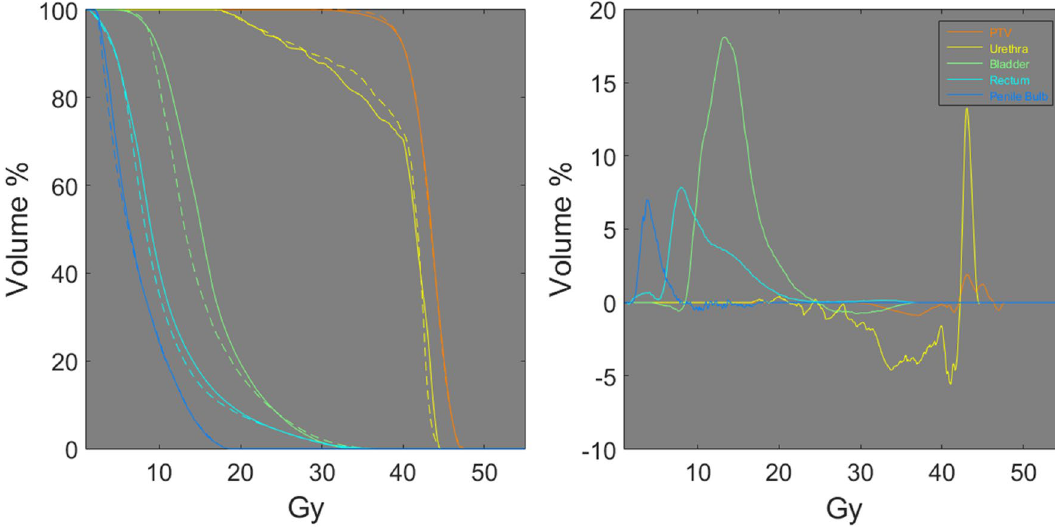
Figure 4. The real DVHs (solid line) (left), DoseGAN DVHs (dashed line) (left) and the DVH differences (right) are shown for a 38 Gy plan. The PTV, urethra, bladder, rectum, and penile bulb are shown in orange, yellow, green, teal, and blue respectively.